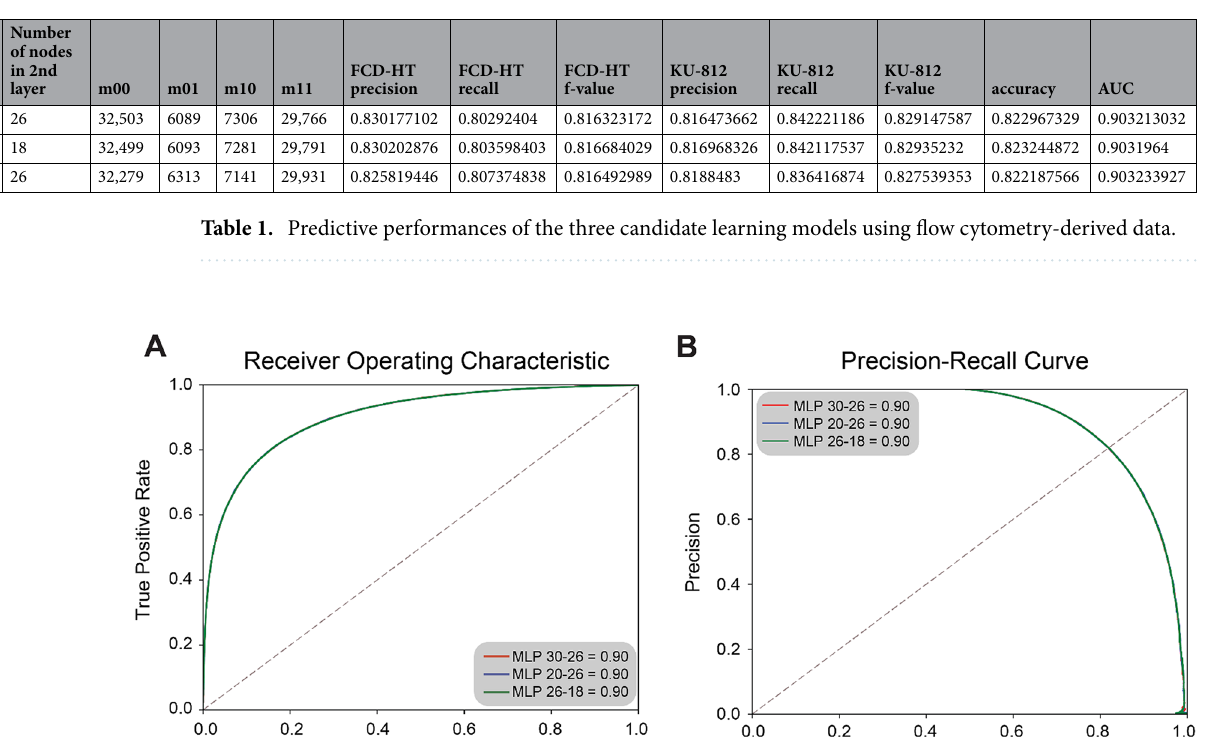
(logistical regression, random forest, k-nearest neighbor, support-vector machine, and multilayer perceptron) were included (model hyperparameters in Supplementary Table 7). Briefly, logistical regression is a statistical model which uses a logistic function to model a binary dependent variable. The model itself is non-linear but can be transformed into a linear regression via link functions. Random forest algorithm is an ensemble learning method which constructs “an ensemble” of decision trees at the training step. K-nearest neighbor algorithm for classification assumes that data points with same classification labels tend to be in proximity. Support-vector machine (SVM) relies on constructing one or a set of hyperplanes in high-dimensional space and remains one of the most robust supervised classification methods. Multilayer perceptron (MLP) belongs to the family of feed- forward artificial neural network (ANN), and typically consist of three layers of nodes: an input layer, a hidden layer, and an output layer. First, using tenfold cross-validation, we screened all models with the standardized training dataset, and adopted the filtering conditions as (1) the mean accuracy > 0.80, and (2) the standard deviation of accuracy < 0.10, which were derived from our previous study using the same 6 flow cytometry-based features to predict mam- malian cell states 24 . In total, one (1) logistic regression model (Supplementary Table 8), 94 random forest models (Supplementary Table 9), 96 k-nearest neighbor models (Supplementary Table 10), two (2) SVM models with linear kernel (Supplementary Table 11), 25 SVM models with Gaussian kernel (Supplementary Table 12), and 893 MLP models (Supplementary Table 13) were selected. Next, all selected models (1111) were trained using the training dataset, and subsequently applied to the standardized testing dataset and subjected to secondary filtering conditions as (1) precision when predicting FCD-HT cells > 0.80, and (2) recall when predicting FCD-HT cells > 0.80. As shown in Supplementary Table 14, only 533 MLP models survived this additional filter. Finally, we chose three MLP models with largest AUC values (Table 1, MLP 20-26: number of nodes in the first layer: 20/number of nodes in the second layer: 26, MLP 26-18: number of nodes in the first layer: 26/number of nodes in the second layer: 18, and MLP 30-26: number of nodes in the first layer: 30/number of nodes in the second layer: 26), and plotted both the receiver operating characteristics (ROC, Fig. 3A) and precision-recall curves (Fig. 3B). The three models displayed essentially identical performance when predicting FCD-HT cells (precision: 0.83, recall: 0.80, accuracy: 0.82, and AUC: 0.90). Cell morphology‑based machine learning models using microscopy‑derived data. In addition to flow cytometry, cell morphology information can also be directly assessed using imaging 28 . Using a Differ- ential Interference Contrast (DIC) microscopy, we prepared 1594 images of individual FCD-WT cells and 1695